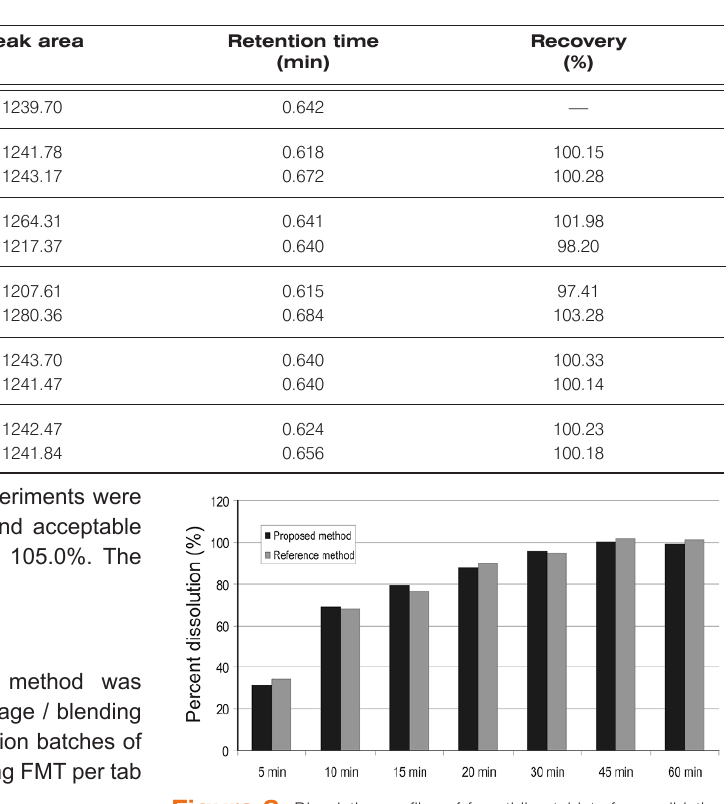
Figure 3. Dissolution profiles of famotidine tablets from validation batches using the proposed (  ) and a reference ( ) HPLC method.